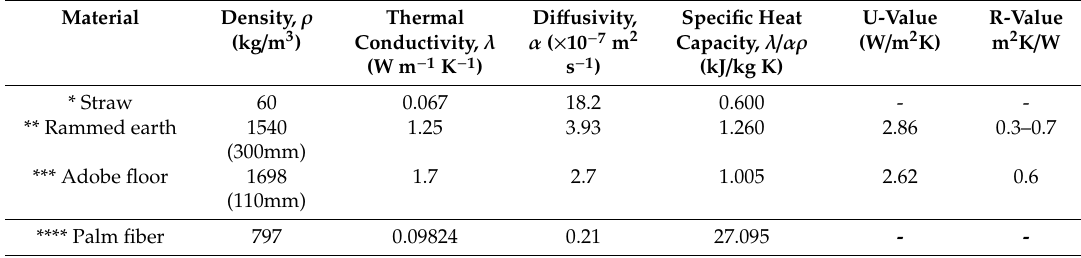
Table 1. The simulation parameters.